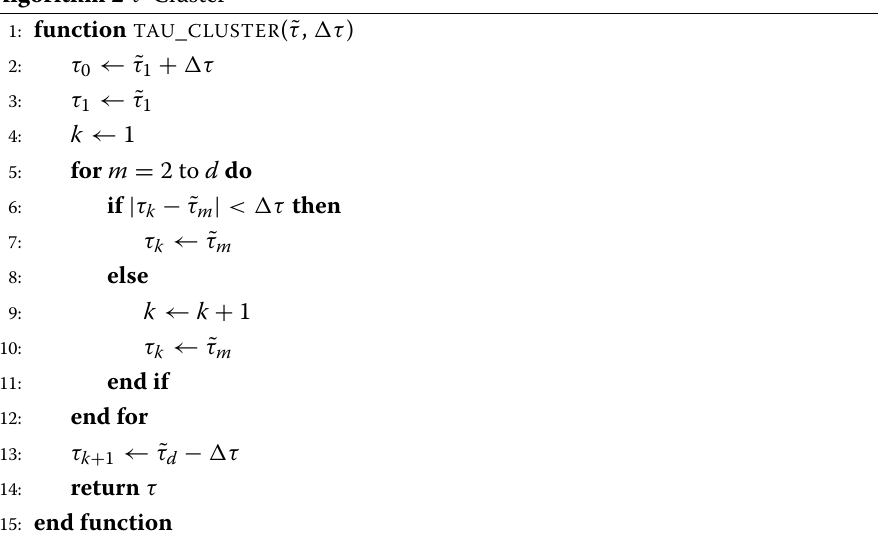
Algorithm 2 τ -Cluster